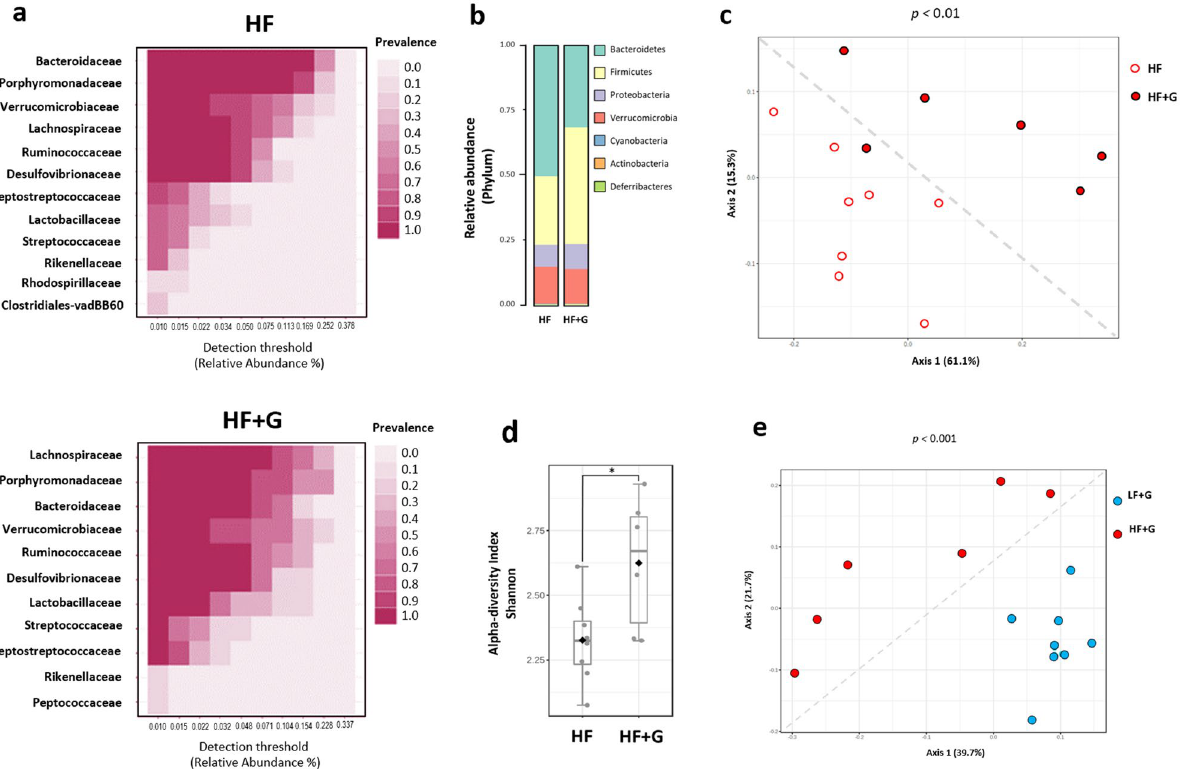
Figure 9. High fat significantly alters microbiota composition upon Giardia infection. The fecal microbiota composition of Giardia -infected HF + G group was investigated at day 7 PI and compared with HF control mice microbiota, respectively (6 to 8 mice per group). Taxonomic identification of the gut microbiota was assessed via 16S rRNA gene sequencing using Illumina MiSeq platform. The 16S rRNA amplicons were clustered into operational taxonomic units (OTU) with a 97% identity threshold. Data are represented using Total Sum Scaling (proportional abundance of species) to remove sequencing-related technical biases. ( a ) Bacterial taxa at the family level based on their prevalence at a given abundance threshold (core microbiota representation; relative abundance %); prevalence scale ranges from 0.0 (white) to 1.0 (dark fuchsia). ( b ) Bar charts representative of the relative abundance of microbial taxa at the phylum level between HF and HF + G groups. ( c ) The β-diversity between HF (white dots) and HF + G (red dots) microbial communities was assessed using Bray–Curtis dissimilarity index and visualized through Principal Coordinate Analysis (PCoA) plot. ( d ) The α-diversity was assessed by calculating Shannon diversity index. Data are expressed as box plots with min/max whiskers; * p < 0.05. ( e ) The β-diversity between LF + G (blue dots) and HF + G (red dots) microbial communities was assessed using Bray–Curtis dissimilarity index and visualized through PCoA plot. n = 6–8 mice per group; one sample from HF Giardia group was removed due to low abundance OTUs and failure to pass the OTU selection step. HF = high fat control mice; HF + G = high fat infected